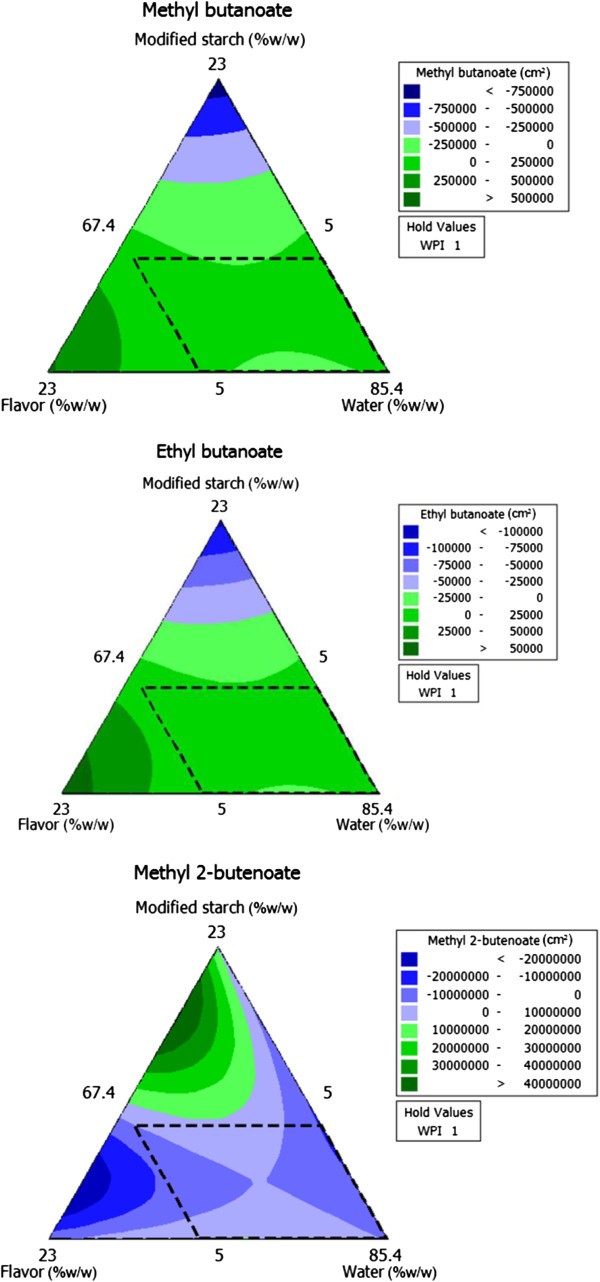
Mixture contour plots of three soursop flavor compounds. Diamond-shaped subregion is the constrained experimental region.